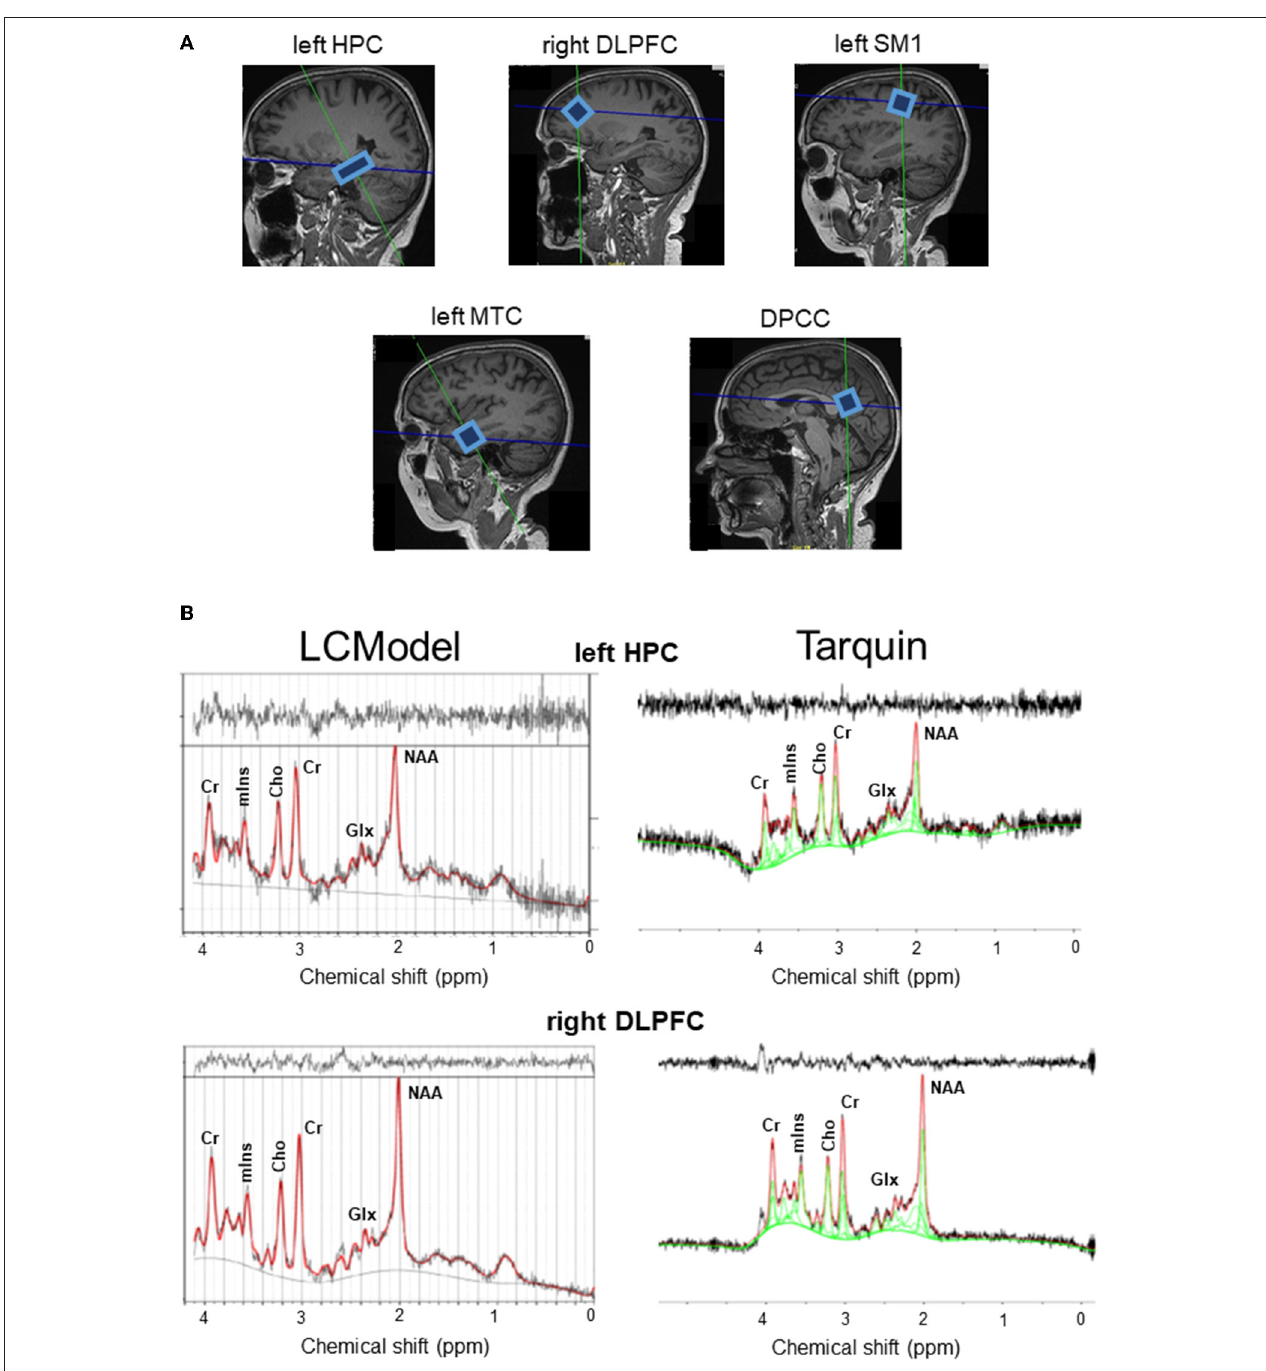
FIGURE 1 | (A) Example voxel positions and spectra from a representative subject. (B) Raw (black curve) and fitted (red curve) spectra from LCModel (left hand side panel) and Tarquin (right hand side panel) are illustrated for the left HPC and right DLPFC. Cho, total choline; Cr, creatine + phosphocreatine; DLPFC, dorsolateral prefrontal cortex; DPCC, dorsal posterior cingulate cortex; Glx, glutamate–glutamine complex; HPC, hippocampal cortex; mIns, myoinositol; MTC, medial temporal cortex; NAA, N -acetyl aspartate; SM1, primary sensorimotor cortex.